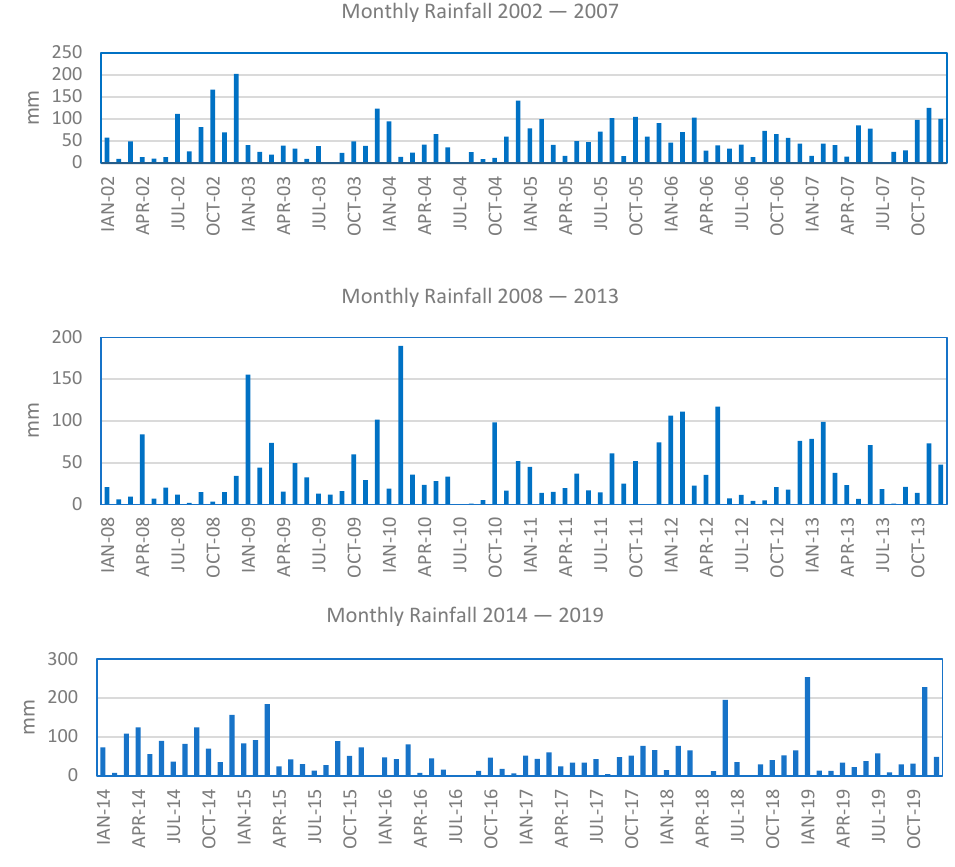
Figure 3. Monthly rainfall charts from Chrysoupolis meteorological station.